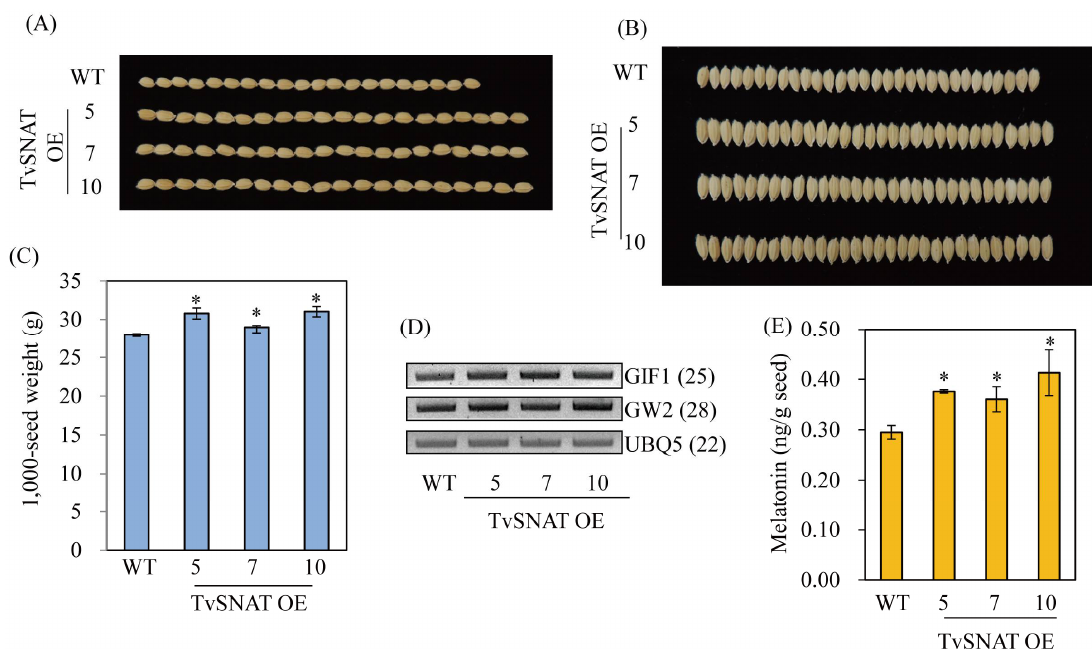
Figure 7. Rice grain morphology and expression levels of seed size-related genes. ( A ) Grain lengths, ( B ) grain widths, and ( C ) 1000-grain weights of the wild-type (WT) and TvSNAT-OE lines. ( D ) Ex- pression levels of rice seed size-related genes determined by reverse-transcription polymerase chain reaction (RT-PCR) in 7-day-old seedlings. ( E ) Seed melatonin content levels. GenBank accession numbers for GIF1 , GW2 , and UBQ5 are Os04g33740, Os02g14720, and Os03g13170, respectively. Numbers in parentheses indicate the numbers of PCR cycles performed. Asterisks indicate significant differences from the WT (Tukey’s honest significant difference test; p < 0.05).